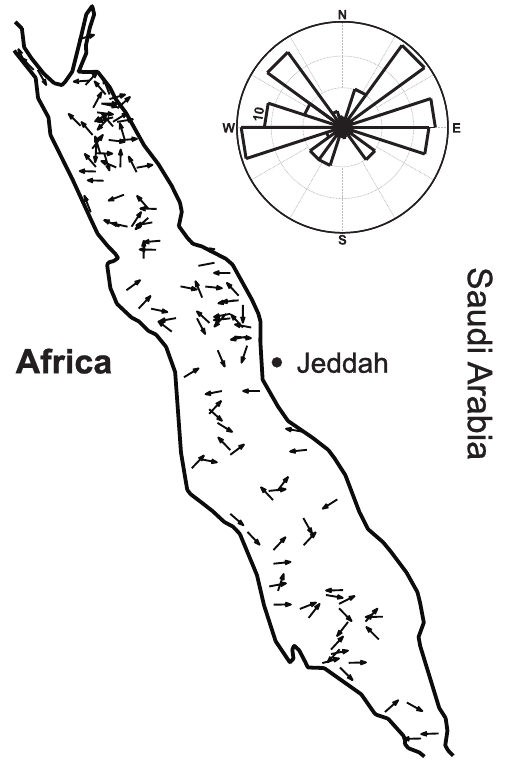
Fig. 5. Map with geographic locations and direction of propagation for all waves in Fig. 4a. At the top right corner an inset shows statistics of propagation directions of the observed AGWs.